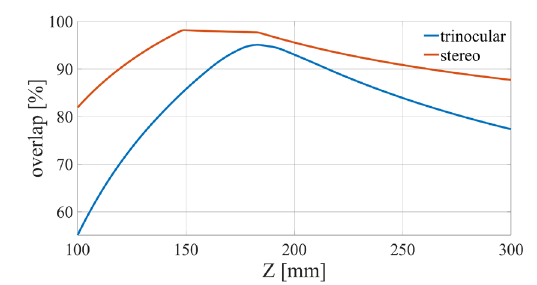
Figure 5. Relative overlap of stereo and trinocular setup as a function of acquisition distance (Z). Orange shows the overlap of camera 1 and 2, blue the overlap of camera 1, 2 and 3. Figure 3. Trinocular camera system observing artificial knee joint (left). Schematic arrangement of two mono- and one RGB camera/s (right).